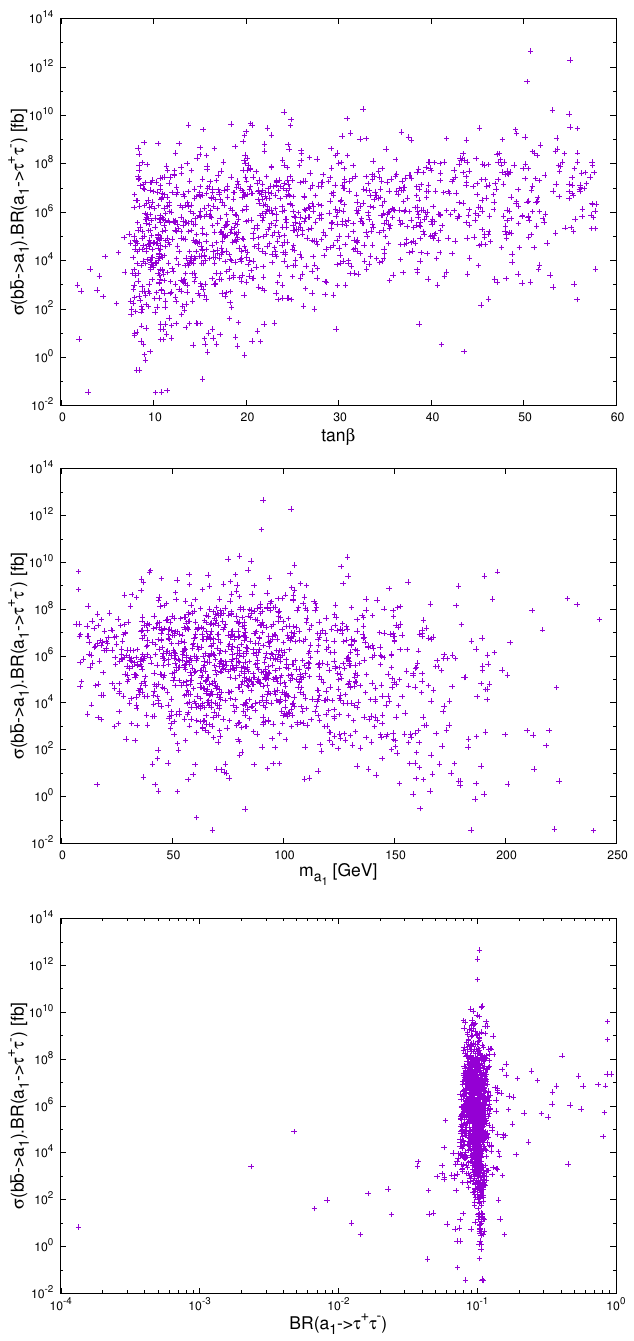
Figure 6. Production rates for the lightest pseudoscalar Higgs state, σ ( b ¯ b → a 1 → τ + τ − ) , as functions of tan β ( top ), m a ( middle ) and BR ( a 1 → τ + τ − ) ( bottom ) [57]. 1 Several analyses for signals and dominant backgrounds for the process b ¯ b → a 1 → τ + τ − were done for the six benchmark points given in Table 2, see Ref. [57] for more details. Figure 7 shows the signal significance and the signal event rates for these benchmark points. As it can be seen from this figure, the LHC has the potential to observe the a 1 signal in the (cid:46) 200 GeV but this requires very high luminosity of 600 fb − 1 or more, range 150 (cid:46) m a 1 see the left plot of the figure. Lighter or Heavier states could not be resolvable via this production